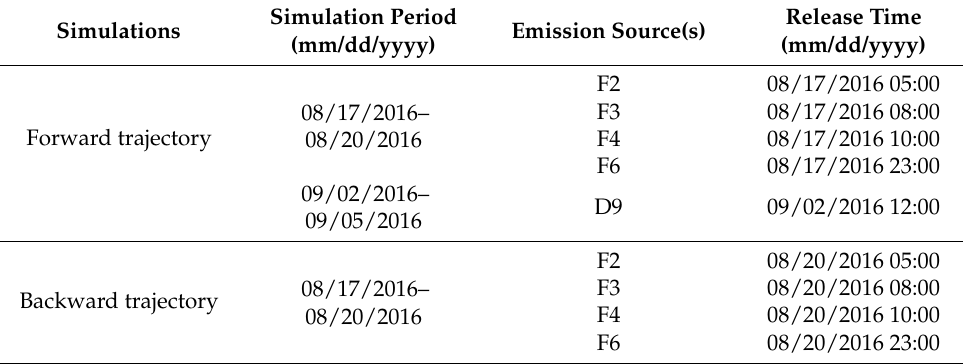
Table 2. The schedule of FLEXPART-WRF